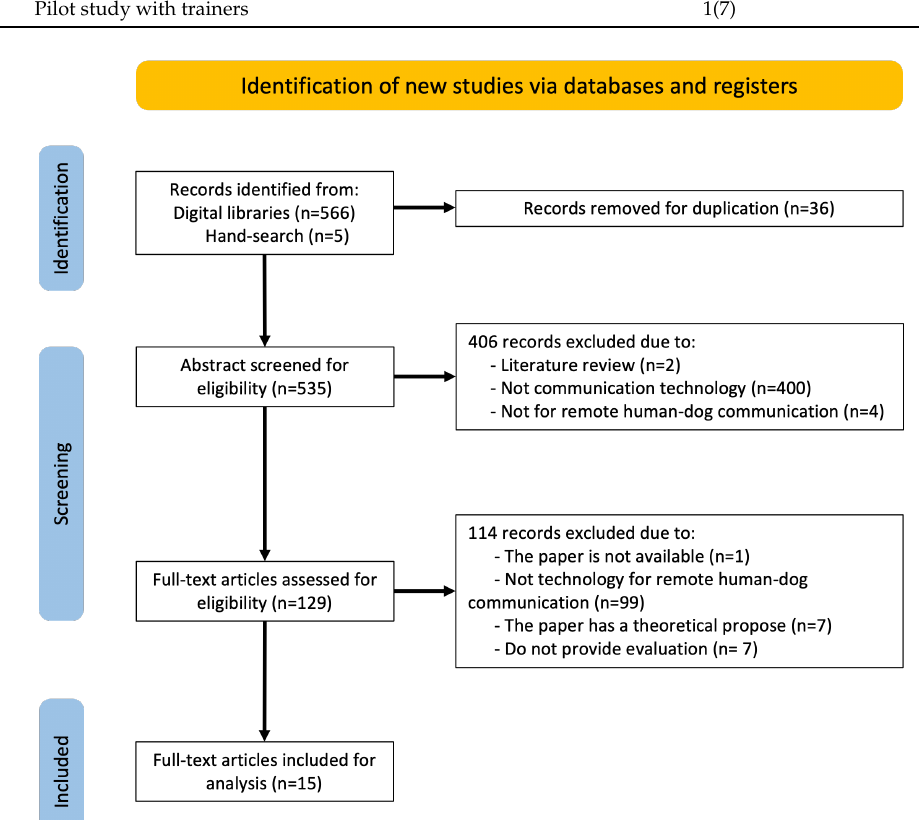
Figure 1. Flow diagram of the study